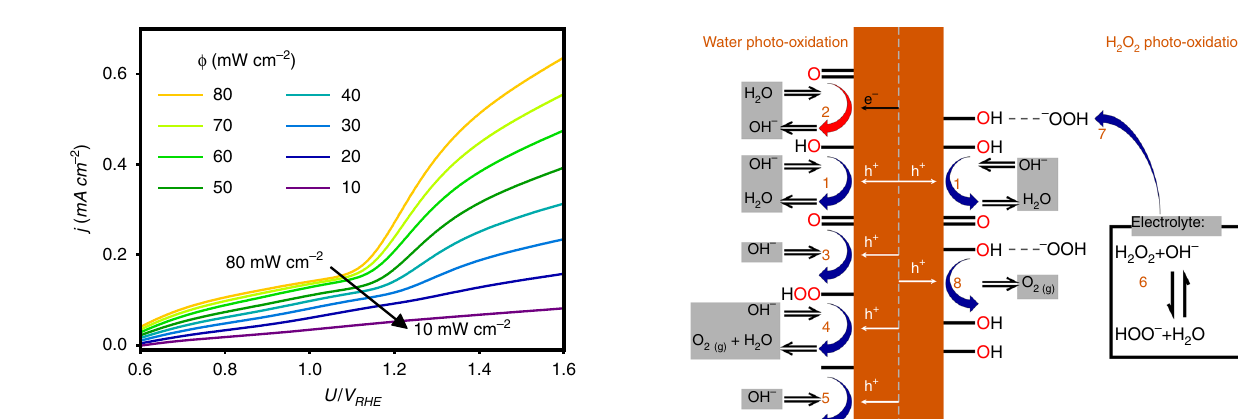
Fig. 2 Photocurrent voltammograms under different illumination intensities. For all measurements H 2 O 2 concentration is at 2.5